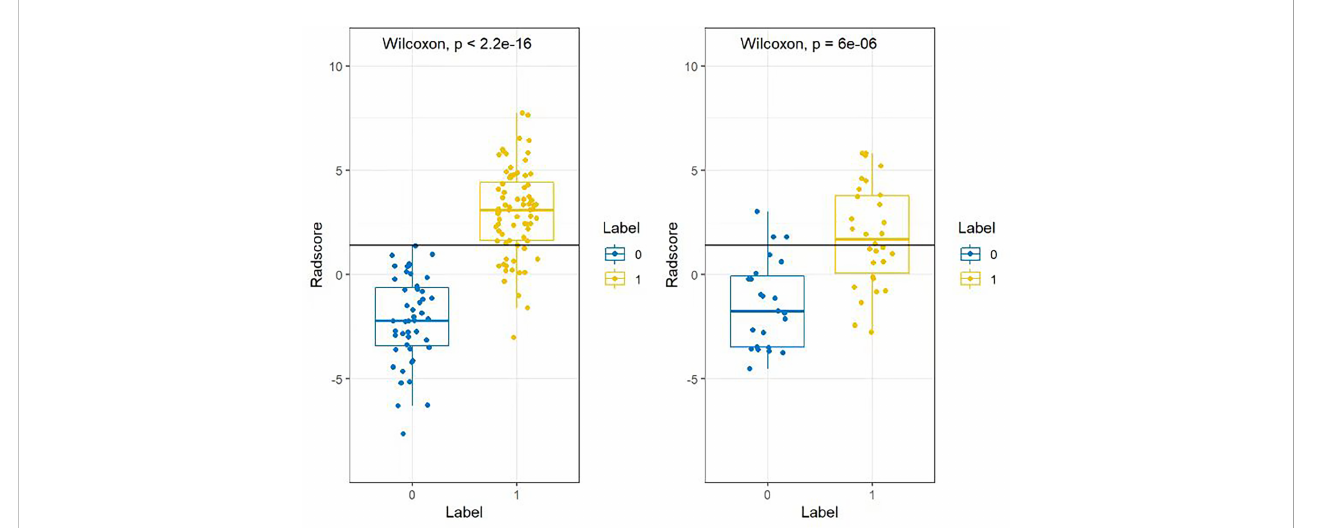
FIGURE 8 Box plot of the radiomics scores of the training group and the test group in model 4. Blue (Label 0) represents the MLN group, and yellow (Label 1) represents the HLN and non-MLN group. The difference between the two groups was statistically signi fi cant ( P< 2.2 e-16 ).